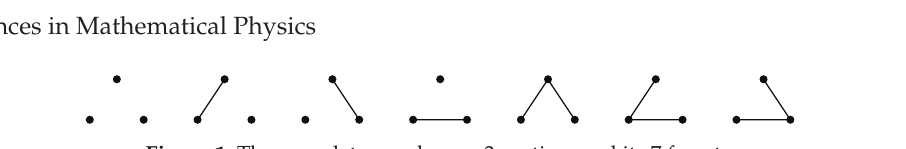
Figure 1: The complete graph over 3 vertices and its 7